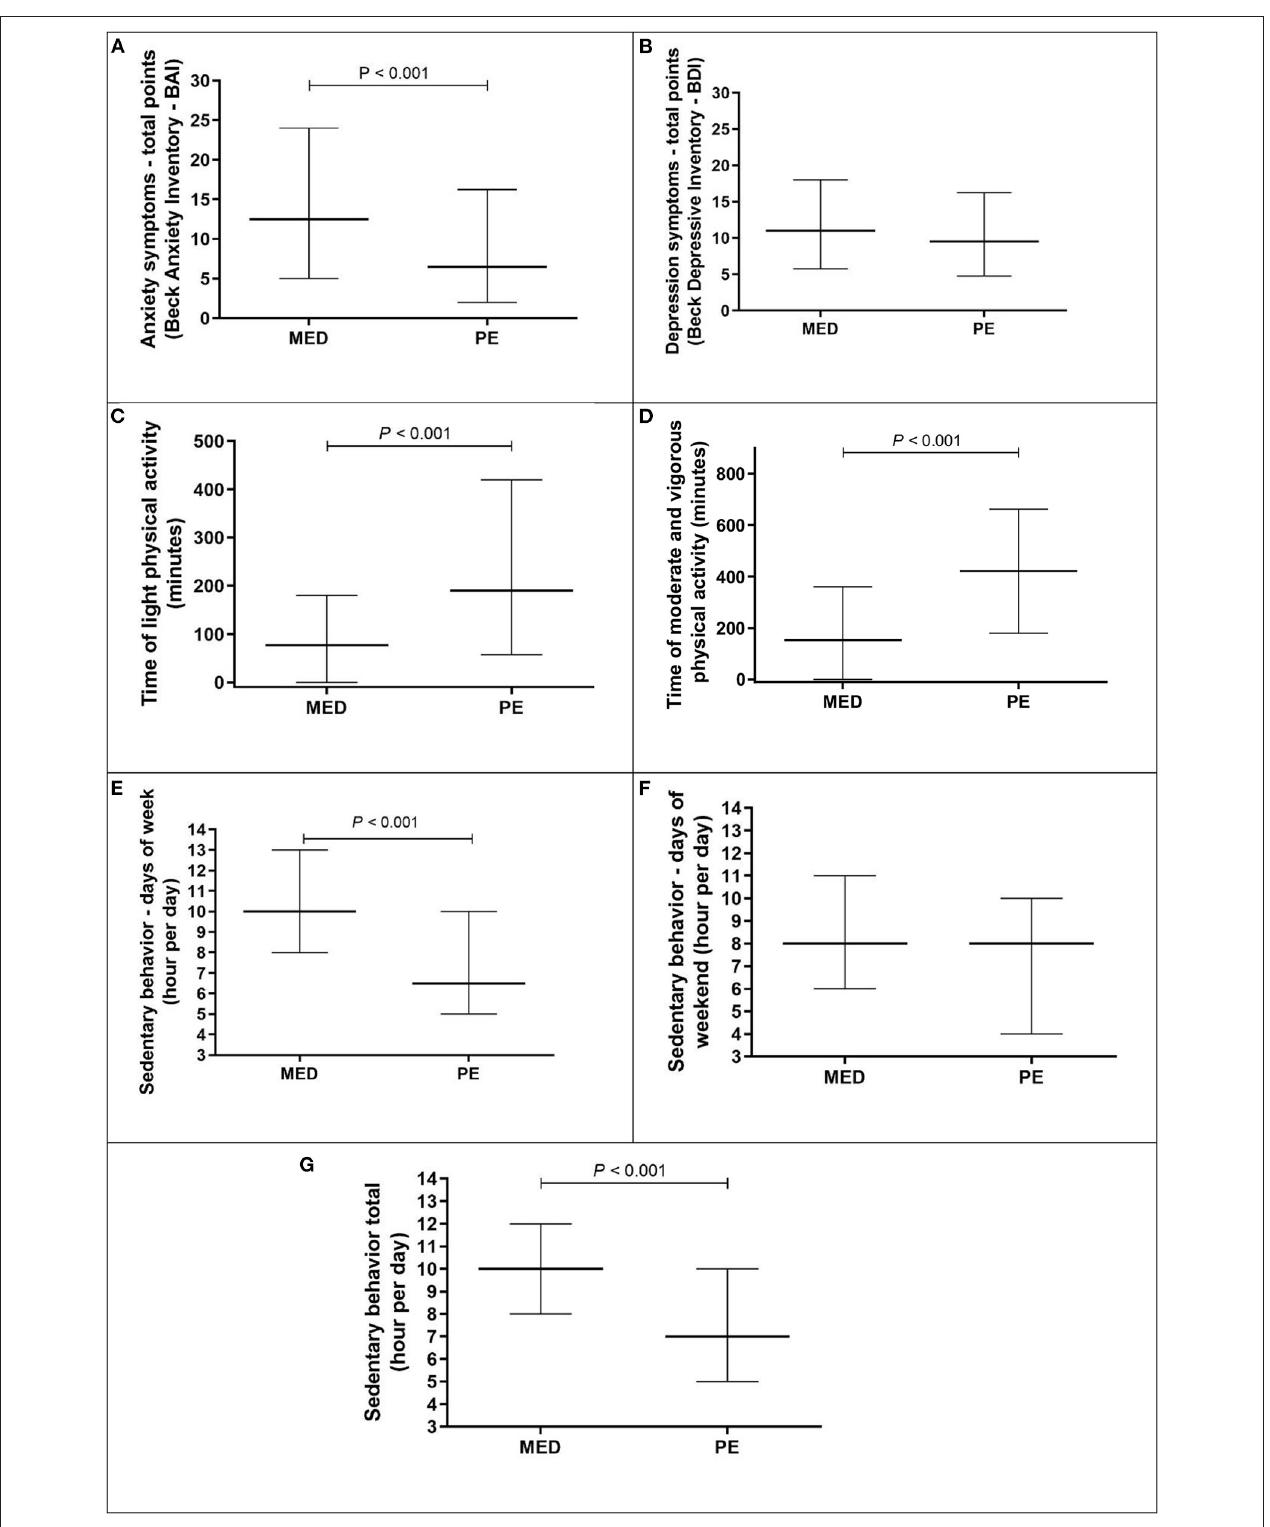
FIGURE 1 | Comparison between medical (MED) and physical education (PE) student regarding anxiety symptoms, depression symptoms, time of light, moderate and vigorous physical activity, and time of sedentary behavior (week, weekend, and total). Data present in median and interval interquartile (25–75). Anxiety Symptoms and Depression symptoms present in total points (0–63). LPA and MVPA are present in minutes per week. Sedentary behavior of week, weekend, and Total are present in hour per day. Panel A - Anxiety symptoms (BAI); panel B - Depression symptoms (BDI); panel C - Light physical activity; panel D - Moderate and vigorous physical activity; panel E - Sedentary behavior days of week; panel F - Sedentary behavior days of the weekend; panel G - Sedentary behavior total.